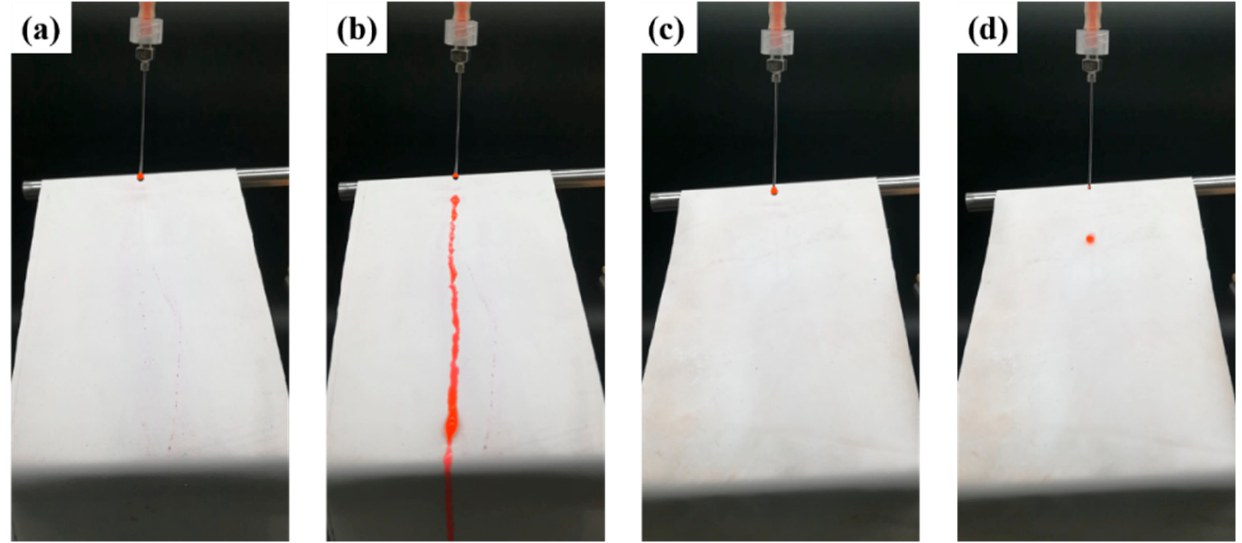
Figure 6. Images that demonstrate the super-hydrophobic property of fibrous membranes, ( a , c ) are the initial states of the SBS and the SBS/PDA/SiO 2 fibrous membranes, ( b , d ) are the final states as the red dye droplets were dripped continuously on the surface of the SBS and the SBS/PDA/SiO 2 fibrous membranes.